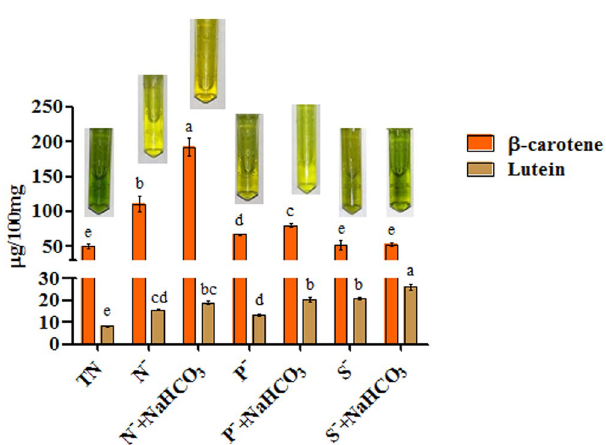
Figure 3. Effect of bicarbonate on β -carotene and lutein of D. salina under nutrient deficit conditions. All values are expressed as Mean ± SD (n = 3). Values with different letters represent significantly differ at p < 0.05 between the groups. Total Nutrient (TN); Nitrate deficit (N − ); Nitrate deficit with bicarbonate (N − + NaHCO 3 ); Phosphate deficit (P − ); Phosphate deficit with bicarbonate (P − + NaHCO 3 ); Sulphate deficit (S − ); Sulphate deficit with bicarbonate (S − + NaHCO 3